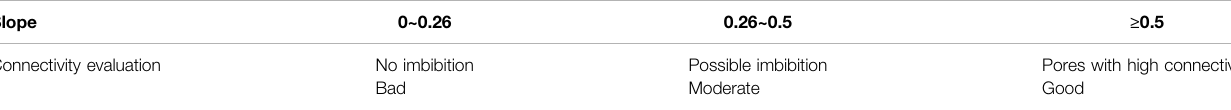
TABLE 5 | Evaluation of reservoir connectivity.